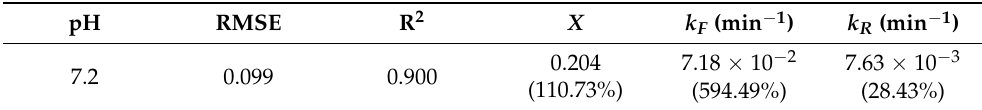
Table 2. Results of fitting the linear superimposition model (LSM) ( i = 1) to experimental data of phenolic compounds release at pH 7.2. Evaluation of the quality of the regression on the basis of RMSE and R 2 . The precision of estimates was evaluated using the SHW% (in parenthesis). pH RMSE R